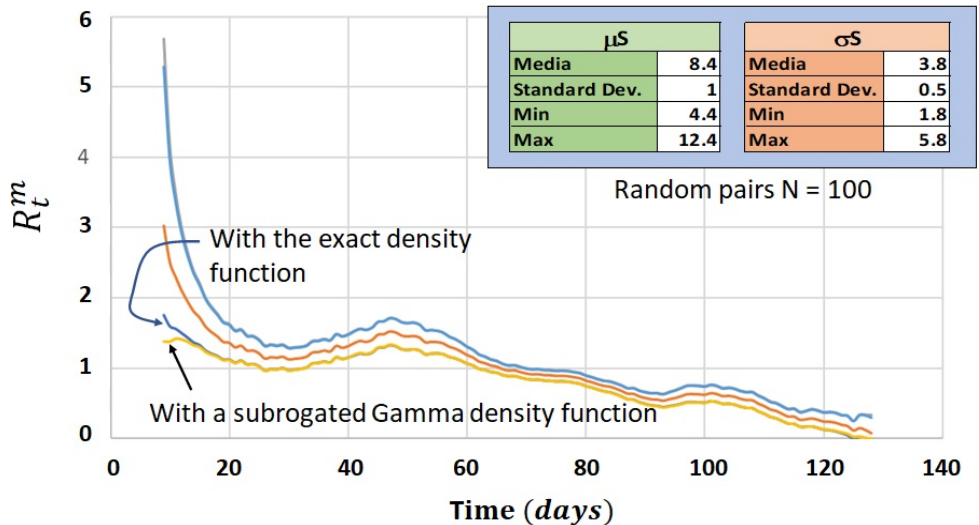
Figure A4. A sample of the Logipow function molded by parameters.